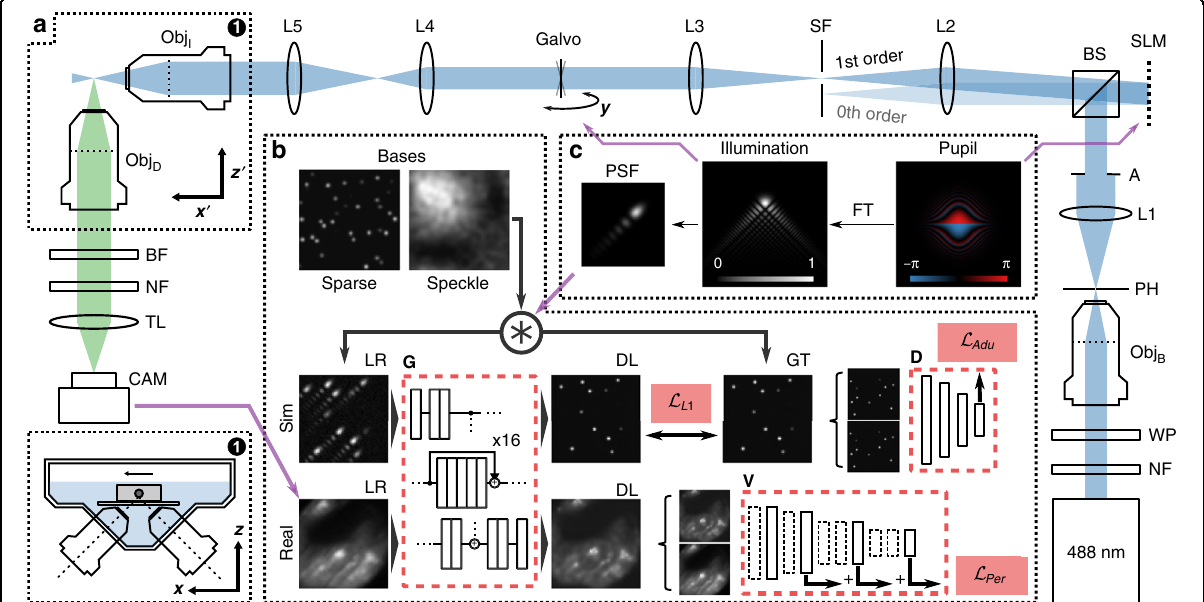
Fig. 1 Light-sheet microscopy system and physics-informed learned deconvolution training. a Optical geometry of the system. Insets marked by (1) show the optical and physical positioning of the sample, which are denoted using the x ′ z ′ and xz coordinates, respectively. b Deep-learning method, consistent with c the physics of beam shaping using a spatial light modulator (SLM). Obj B, I, D: objectives for beam expansion, illumination and detection, respectively. A 488-nm laser source is fi ltered using a notch fi lter (NF), half-wave plate (WP), pinhole (PH) and aperture (A). L1-5: lenses. BS: beamsplitter. The SLM shapes the illumination fi eld in diffraction mode to match the pupil function in ( c ), which is fi ltered using a spatial fi lter (SF) and scanned as a light sheet using a galvonometer-driven mirror. Sample fl uorescence fi ltered using a bandpass fi lter (BF) and a notch fi lter (NF),